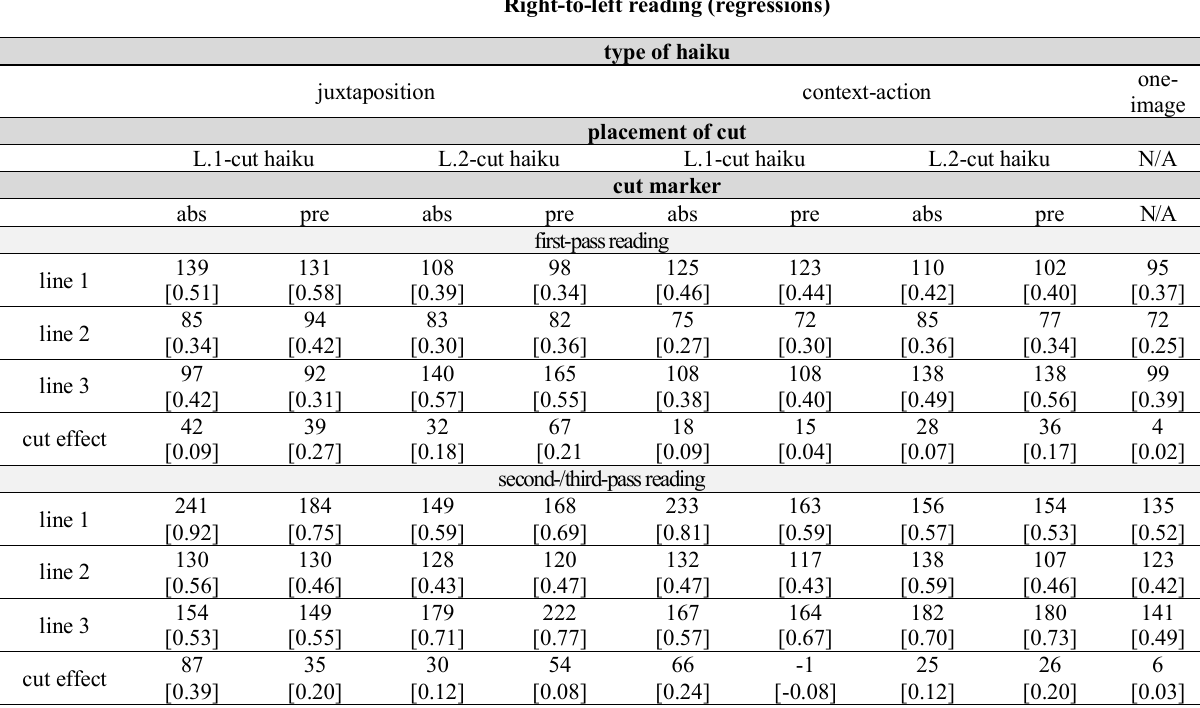
Table 3 . Fixational dwell times (per word) following regressive saccades during first-pass (top-half) and second-pass (bottom-half) reading in milliseconds (number of fixations given in parentheses). Dwell times are normalized per word to correct for differential line lengths in terms of word number among the three poem lines. The extended time spent on the fragment line (line 1 in L.1-cut and line 3 in L.2-cut haiku) relative to the [remote] phrase line (line 3 in L.1-cut and line 1 in L.2-cut haiku) represents the cut